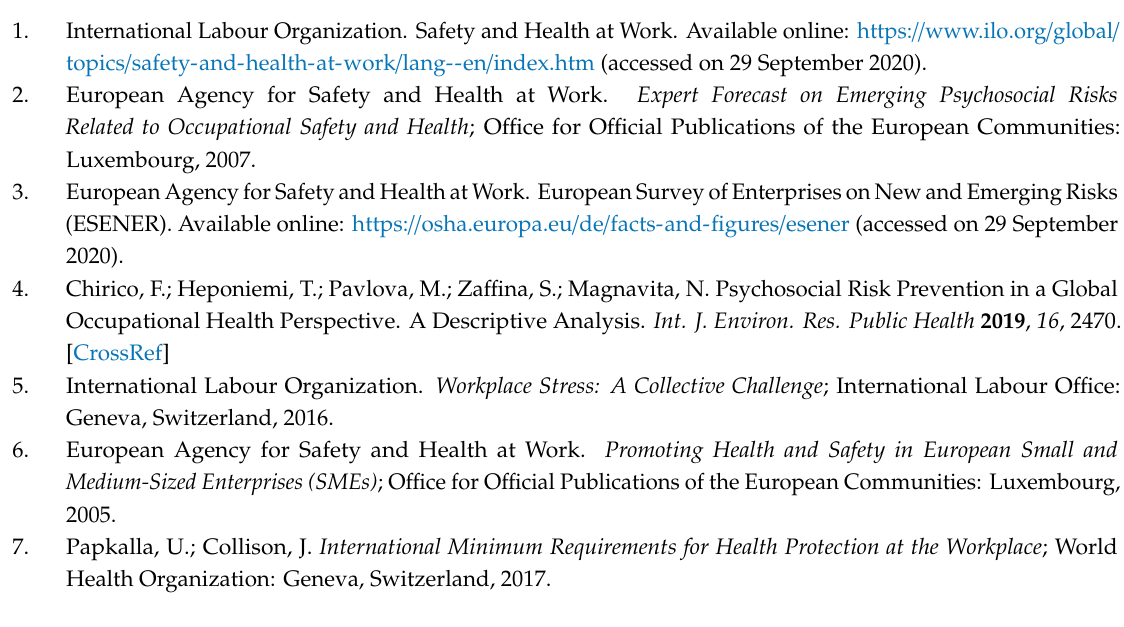
Table S1: Search Strategy for Pubmed (NCBI), Table S2: Summary of study characteristics, Table S3: Allocation to economic sectors according to the International Standard Industrial Classification of All Economic Activities